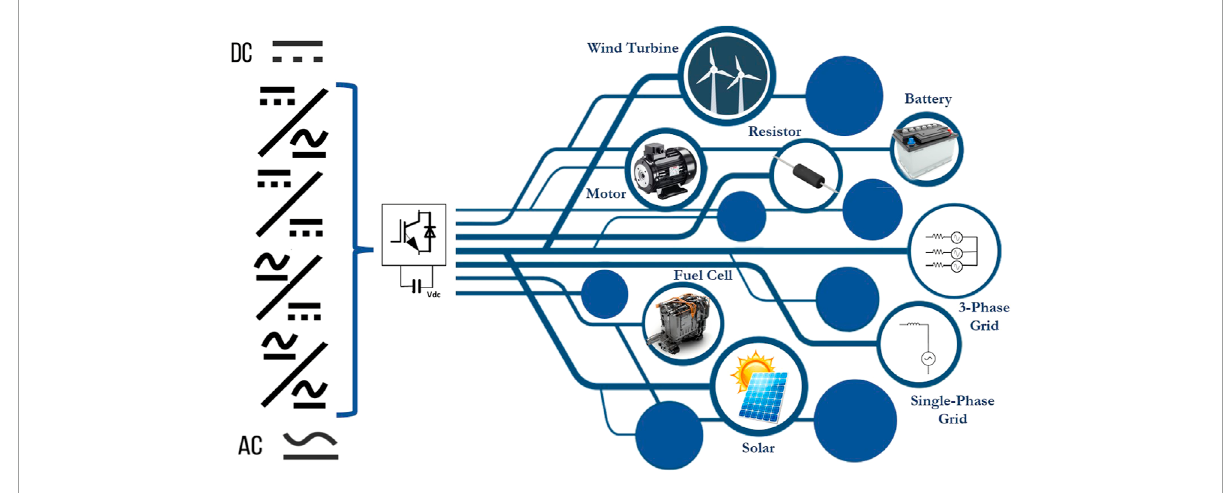
FIGURE 1 Power converters in modern energy conversion